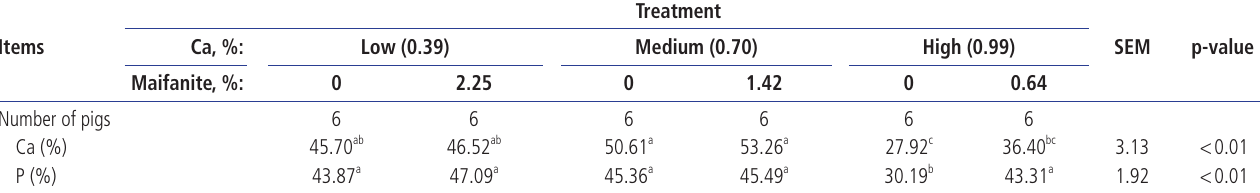
Table 3. Apparent total tract digestibility (ATTD) of Ca and P in pigs fed experimental diets with indicator marker (IM) method (as-fed basis)